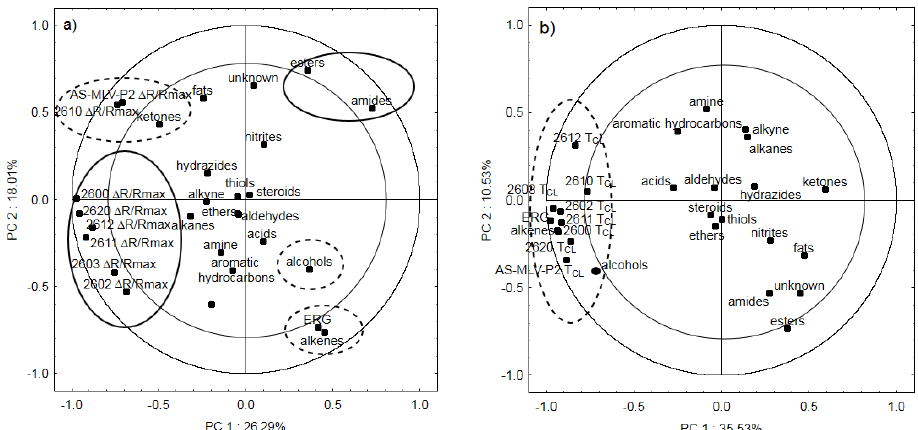
Figure 7. ( a ) location of loading vectors relative to the first two principal components (PC1, PC2) from eight sensor readings for ∆ R / R max , ergosterol, and chemical groups of compounds obtained for 31 days of storage; ( b ) location of loading vectors relative to the first two principal components (PC1, PC2) from eight sensor readings for TCL, ergosterol, and chemical groups of compounds obtained for 31 days of storage.